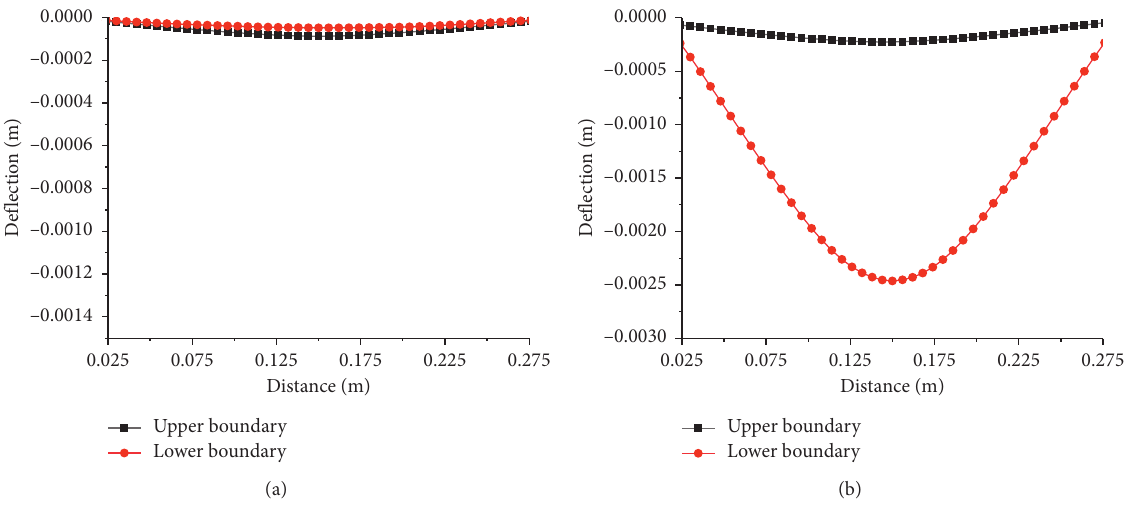
Figure 13: Deflection of the RC beam with different corrosion expansion pressures: (a) no corrosion and (b) 2% corrosion expansion pressure.